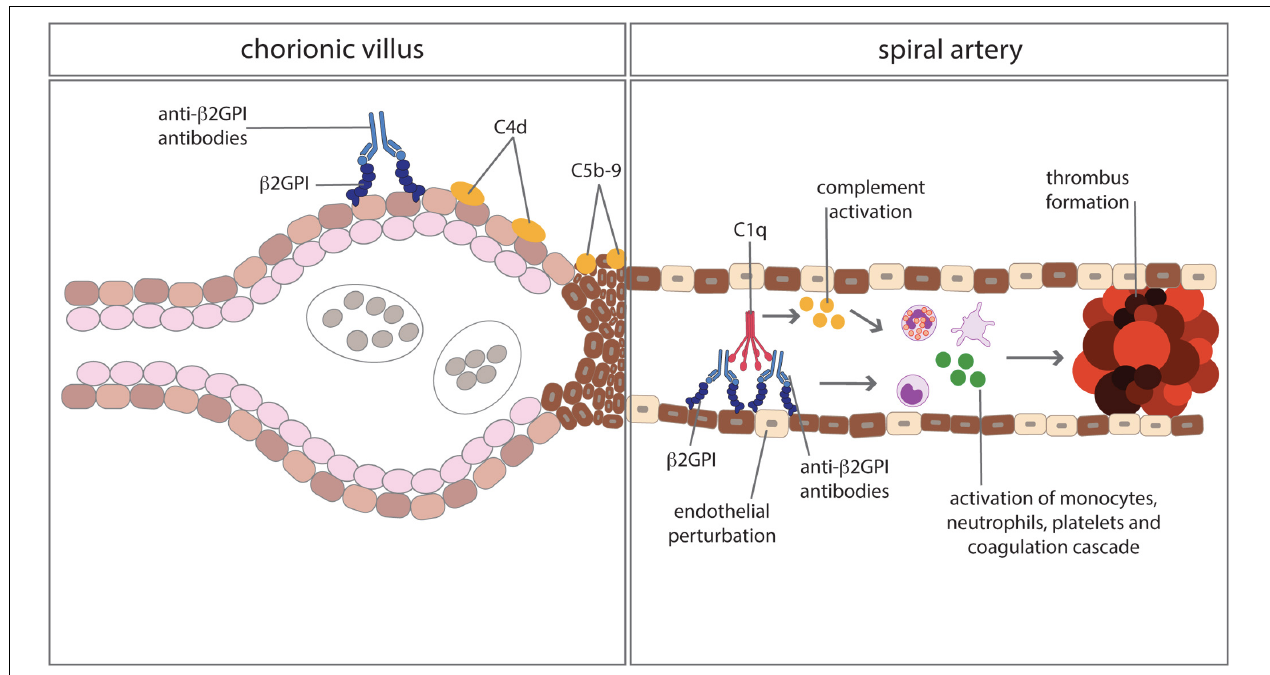
FIGURE 3 | Complement-mediated biological effects at placental level in anti-phospholipid syndrome. Complement activated by antibodies interacting with β 2GPI bound to trophoblasts and vascular endothelium of decidual vessels leads to cell damage and promotion of thrombus